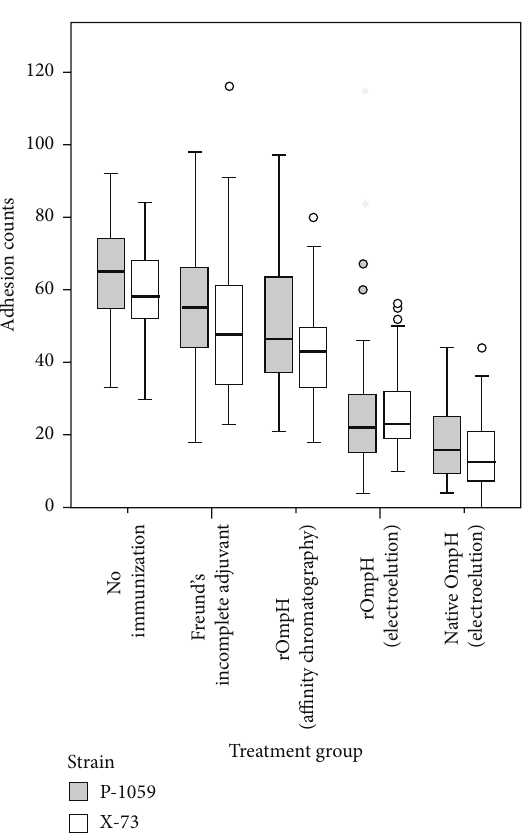
Figure 4: Box-and-whisker plot of counts of adhesions to CEF cells by treatment group and P. multocida challenge